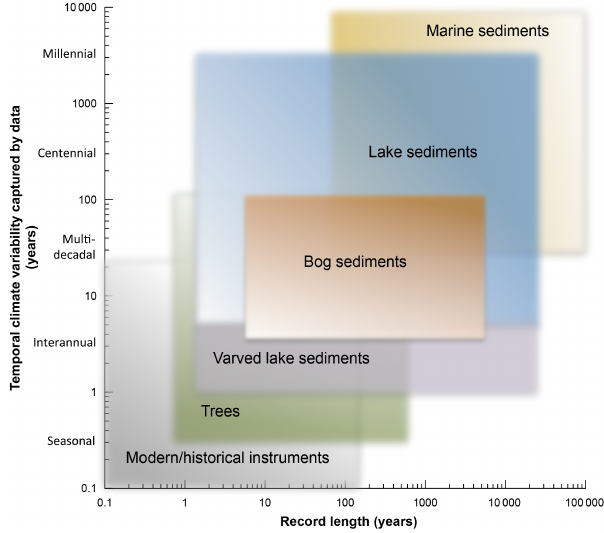
Figure 3. Temporal climate variability captured and typical record lengths characteristic of paleoclimate data available in the NE